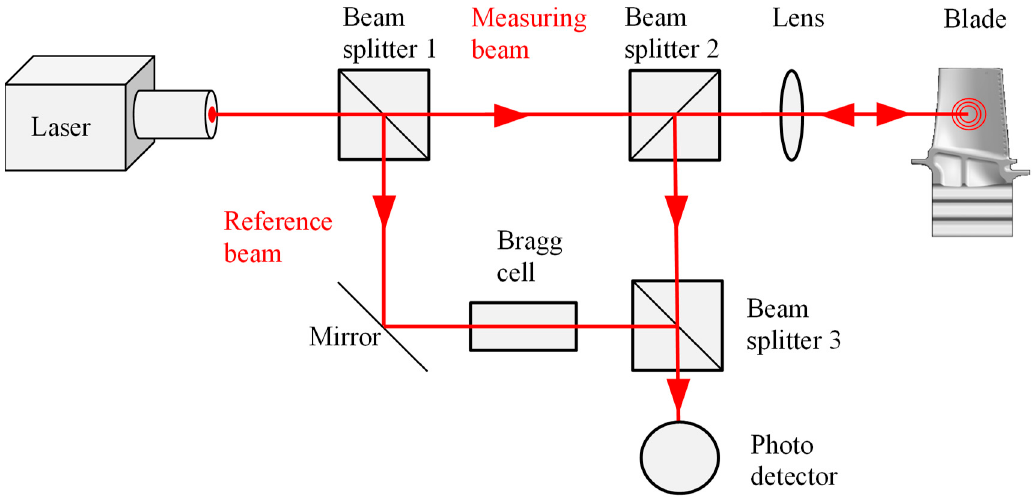
Figure 10. Principle sketch of a laser Doppler vibrometer system.